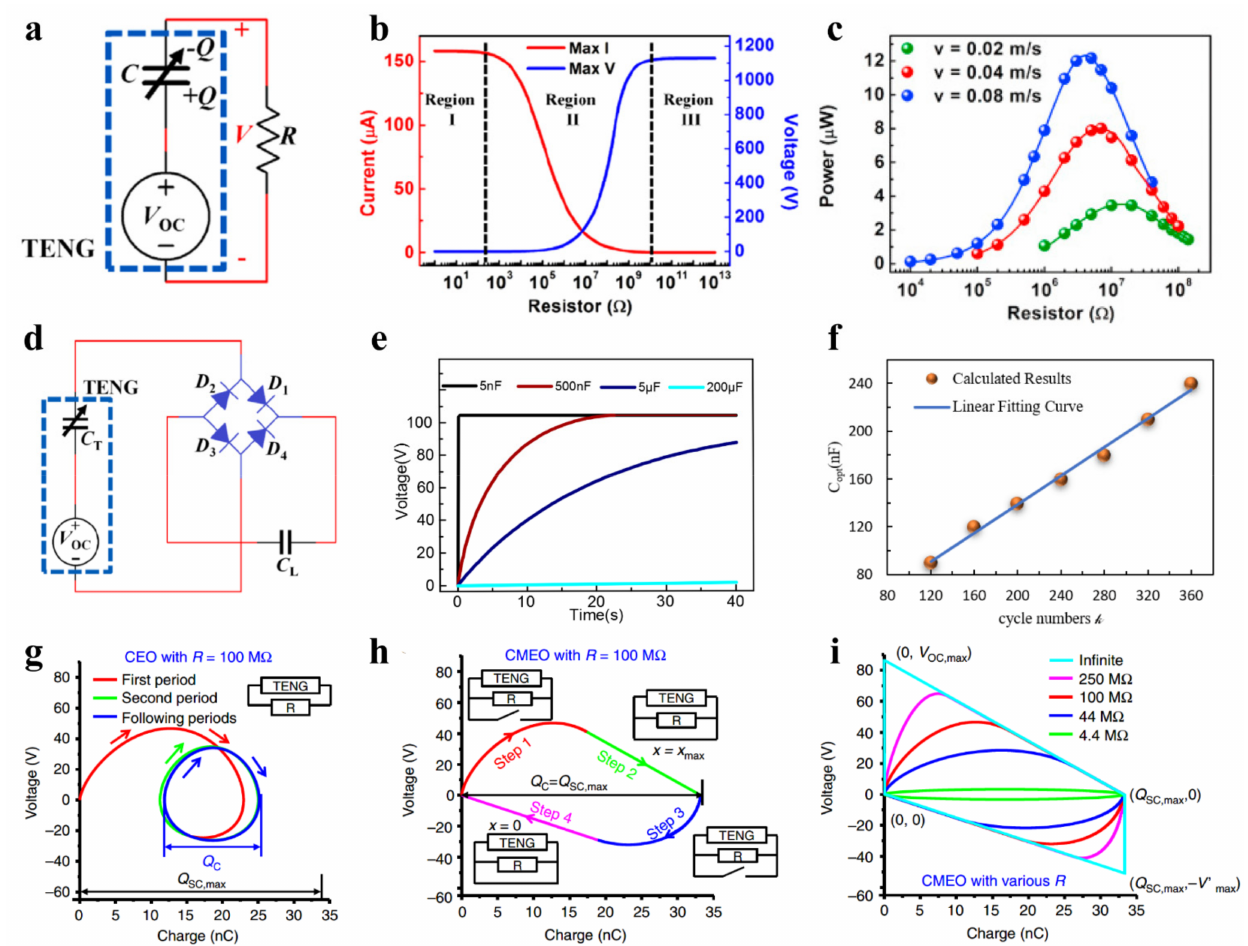
Figure 2. Fundamentals of switching power management for TENG. ( a ) TENG connected with resistances load. ( b ) ‘Three-region’ characteristics under resistive load. ( c ) Dependence of the power on external load and velocity. ( d ) Full-wave rectifier circuit. Reproduced with permission [33]. Copyright 2014, Elsevier. ( e ) Saturation curve of capacitor voltage. ( f ) Relationship between optimal matching capacitance and numbers of charging cycle [39]. ( g ) Cycles for energy output under 100 M Ω . ( h ) Four steps of cycles for maximized energy output (CMEO) under 100 M Ω . ( i ) CMEO under infinite load. Reproduced with permission [61]. Copyright 2015, Nature